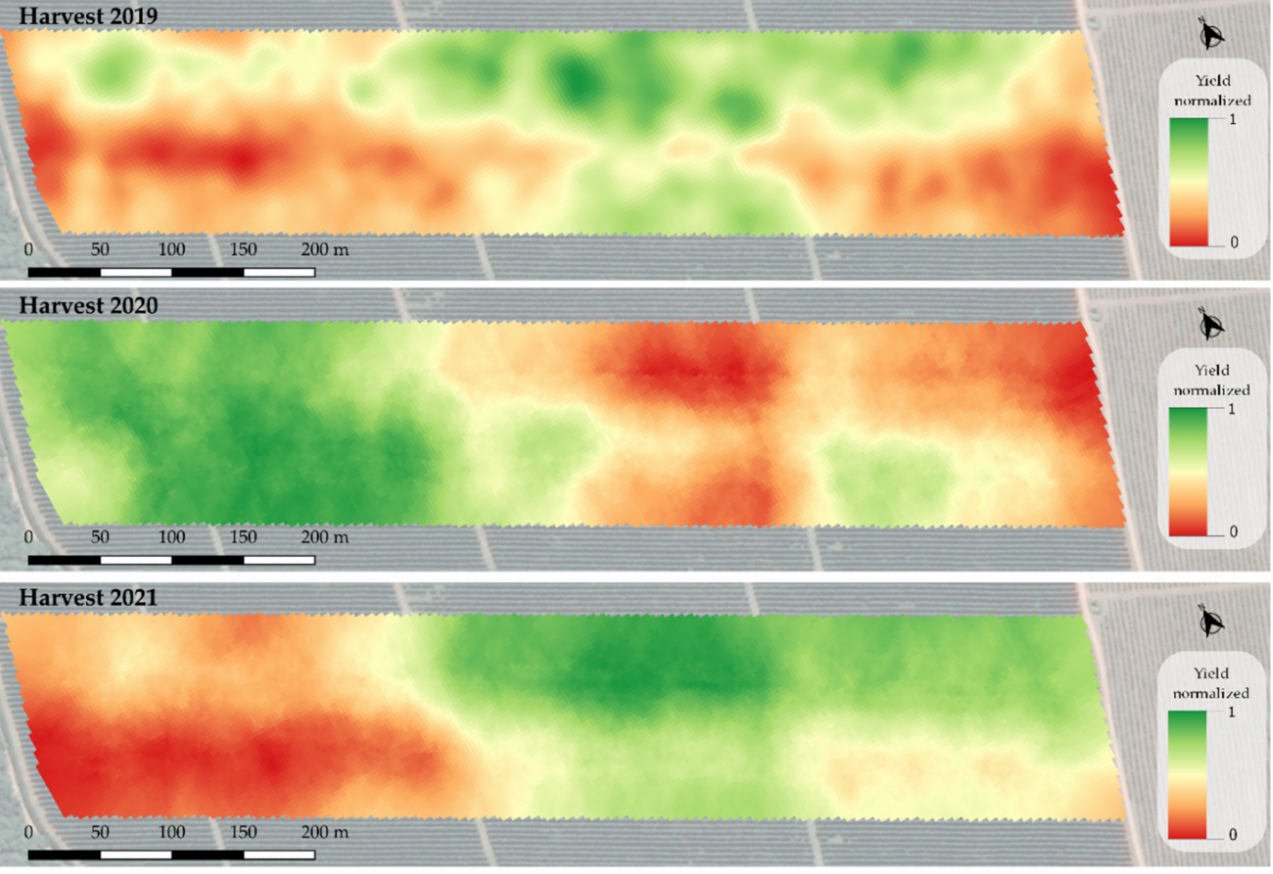
Figure 7. Normalized yield map for the harvest in 2019, 2020, and